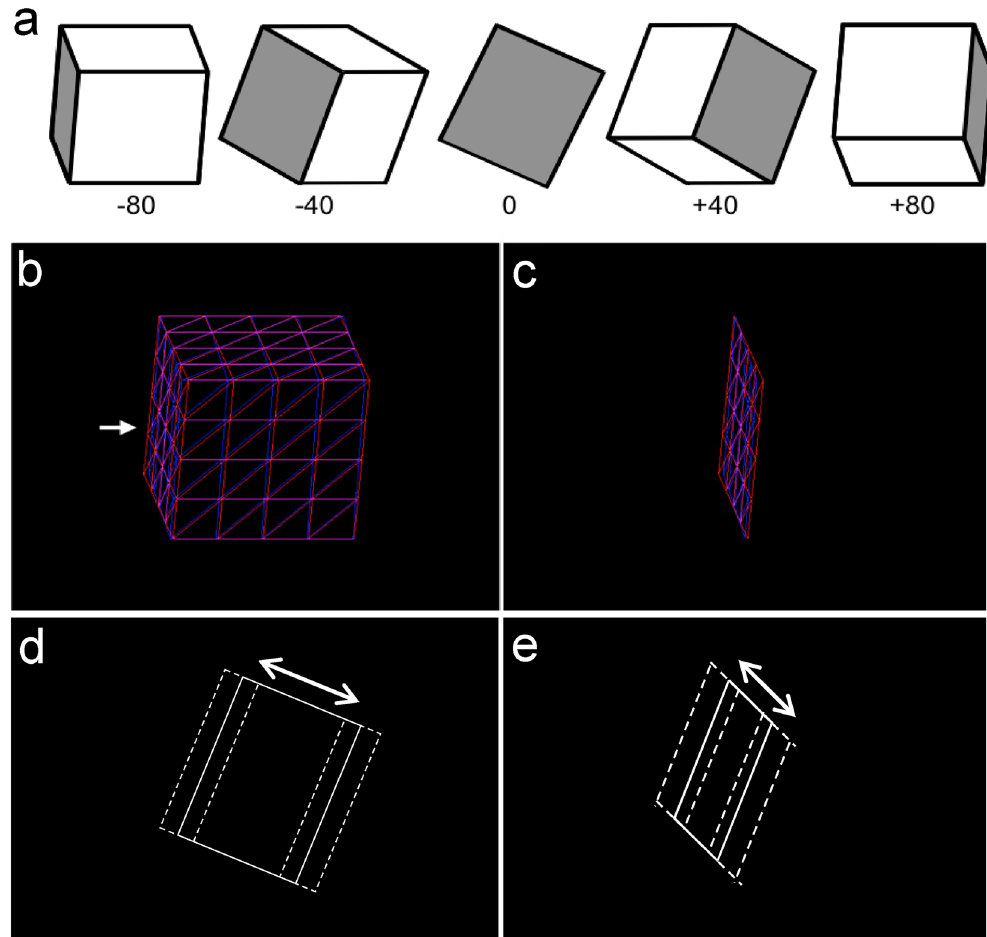
Figure 1. Example stimuli and response probes for the shape judgement task. ( a ) Schematic of stimuli which were polyhedrons rotated in different directions (rotated ± 40°, ± 60°, or ± 80°; the 0-degree stimulus was not presented); the face of interest is highlighted in gray. Example stimuli, which were computer-generated red/ blue anaglyphs, are shown for context-present ( b ) and context-absent ( c ) blocks. Participants judged either the rectangle’s objective (physical) width, which remained constant at varying angles of rotation, or the rectangle’s projective width (the width in the picture plane). Thus, there were four block types consisting of a cross of context (present, absent) and judgement (projective, objective) types. For the context-present conditions, a white arrow (shown in b ) indicated the face of interest that should be attended for the subsequent matching judgement. Example response probes are shown for objective ( d ) and projective ( e ) blocks. Participants had to adjust the width of the initial response parallelogram to match the previously seen stimulus. The initial response parallelogram was presented as a white outline. Example wider and narrower adjustments are indicated with dashed